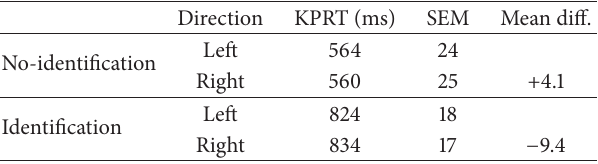
∗ Paired comparison significant at Bonferroni corrected P < .05. Table 2: Key-press RT in milliseconds (ms) for the two-way interaction of target-feature-identification × direction from